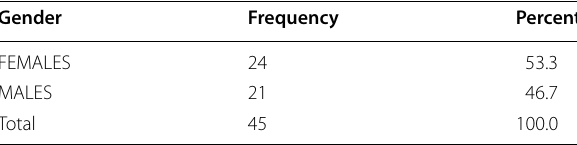
Table 2 Gender-wise distribution of